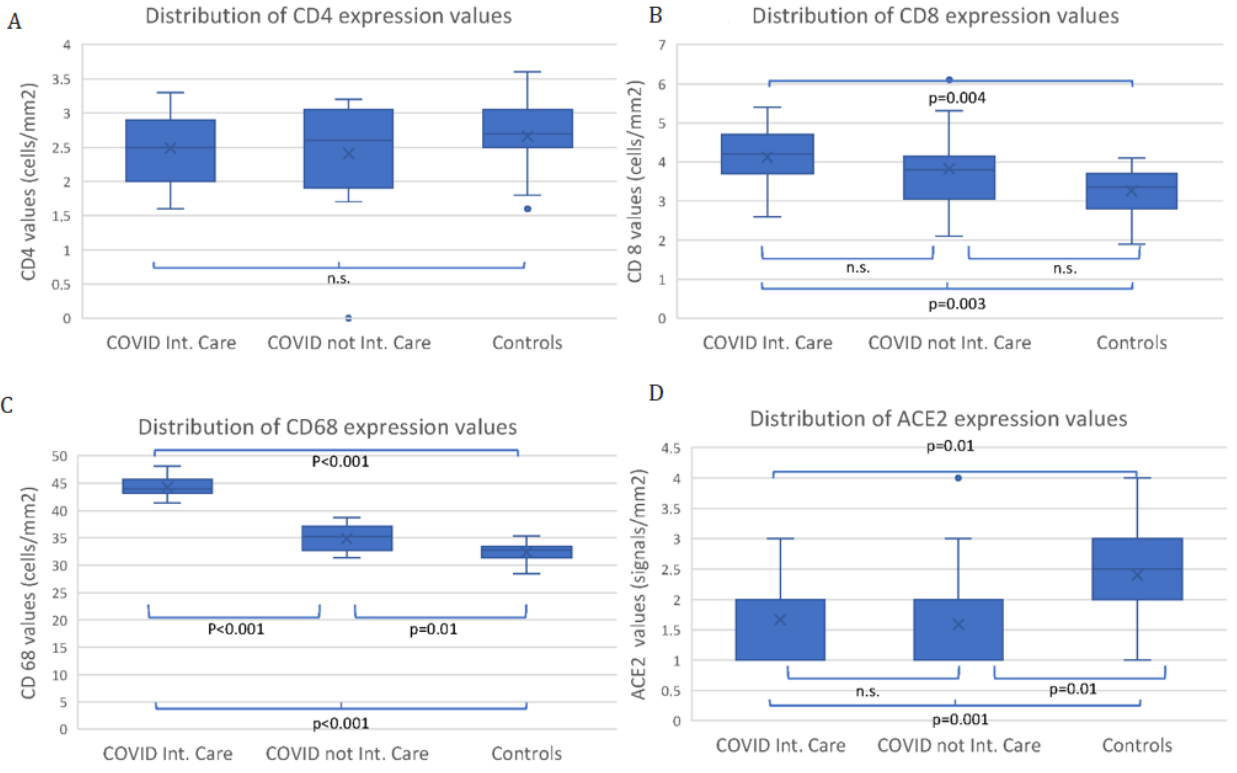
Figure 6. CD4( A ),CD8( B ),CD68( C )andACE2( D )expressionvaluesintheCOVIDInt. Care(13patients), COVID not Int. Care (16 patients) and Controls (28